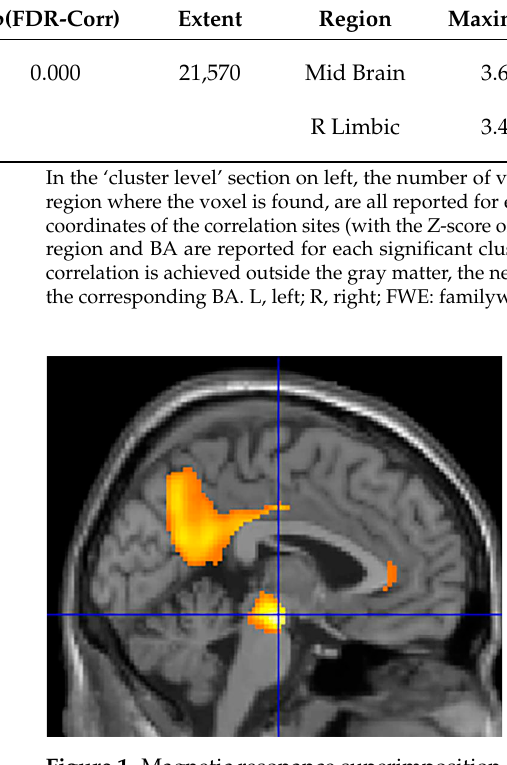
Figure 1. Magnetic resonance superimposition of the data presented in Table 1 showing an increased glucose consumption in the substantia nigra and in the posterior cingulate cortex (sagittal view). Table 1. Regression analysis showing the CSF DAT levels-related areas of increased 18F-FDG brain uptake.